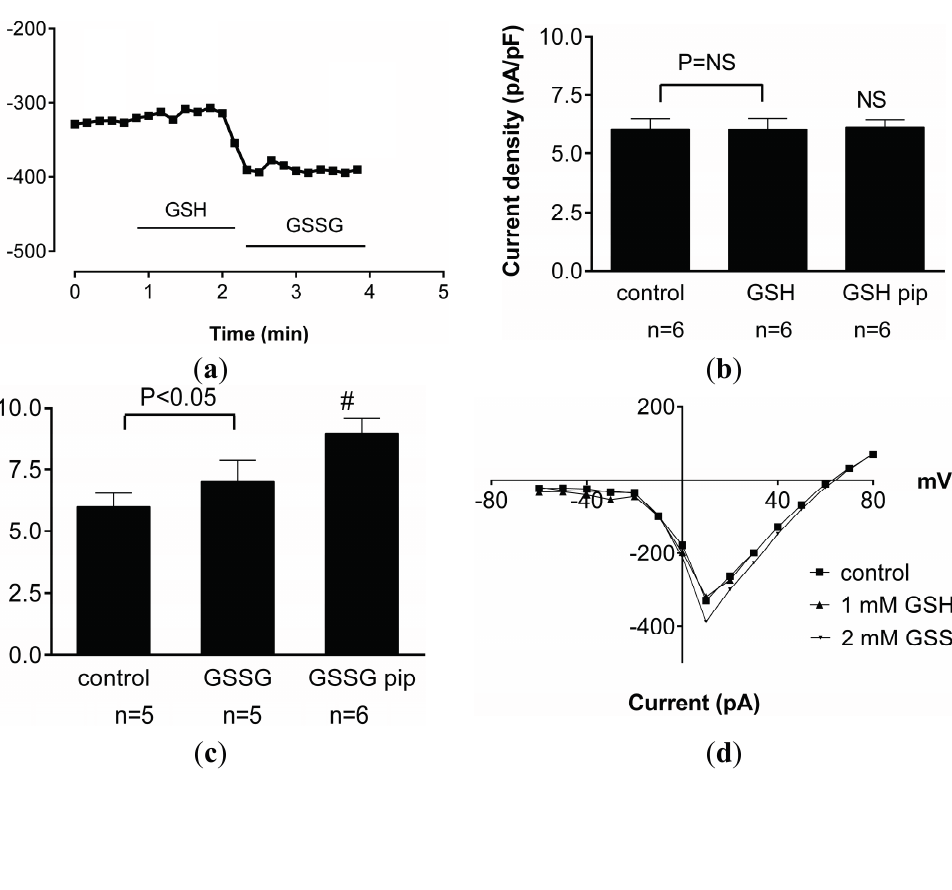
Figure 3. Oxidative stress causes persistent enhancement of the L-type Ca 2+ channel via ROS-mediated glutathionylation. ( a ) Time course of changes in membrane current recorded from guinea pig cardiac myocytes during extracellular exposure to 1 mM GSH followed by 2 mM GSSG as indicated; ( b ) Mean (±SEM) of L-type Ca 2+ channel current density under control conditions (no drugs) and after exposure to GSH applied either extracellularly or in the patch pipette (GSH pip). NS, not significant; ( c ) Mean (±SEM) of L-type Ca 2+ channel current density under control conditions (no drugs) and after exposure to GSSG applied either extracellularly or in the patch pipette (GSSG pip). #, p < 0.05 vs. control; ( d ) Current-voltage relationship for representative myocytes during voltage steps from − 60 to +80 mV and exposure to GSH or GSSG as indicated; ( e ) Representative single channel currents recorded at − 100 mV in the absence and presence of 200 µM DTNB followed by 1 mM DTT and then 2 µM nisoldipine. The open probability ( P 0 ) for each treatment is indicated; ( f ) Immunoblot demonstrating glutathionylation of protein after probing with anti-GSH antibody ( left ) and anti-channel antibody ( right ) in immunoprecipitated Ca v 1.2 channel protein samples from control nonischemic human heart (Con) and ischemic human heart (IHD); ( g ) Densitometry analysis of immunoblots for glutathionylated protein band normalised to the channel protein in the same lane for Con samples and IHD samples (mean ± SEM); and ( h ) Concentration of protein-glutathione mixed-disulfides in channel protein from Con and IHD heart samples (mean ± SEM). Reproduced with permission from